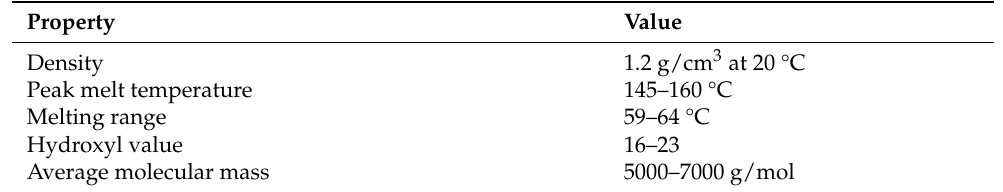
Table 2. Physical and chemical properties of PEG 6000 g/mol.